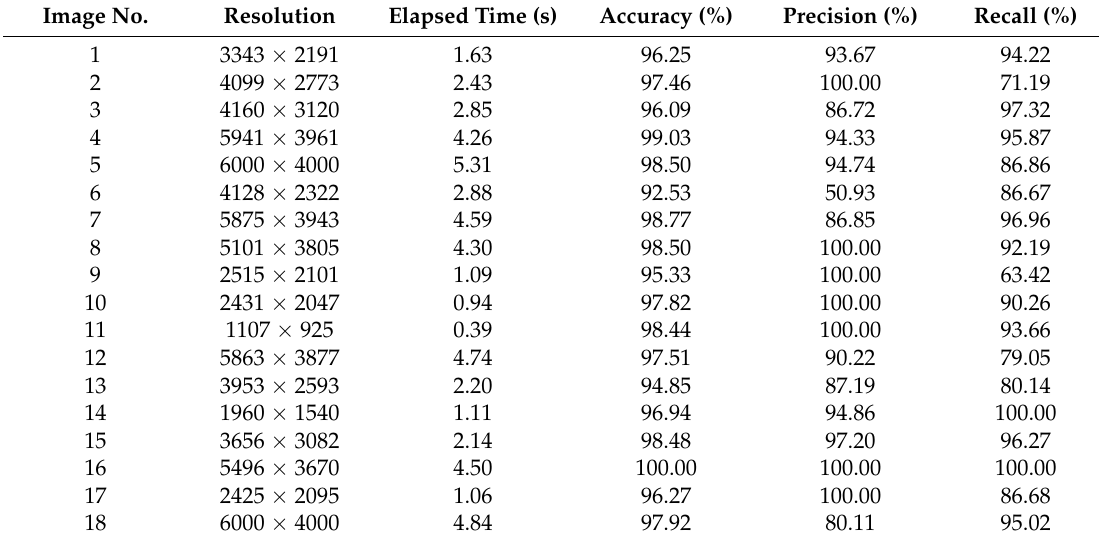
Table A1. Crack detection result of forty